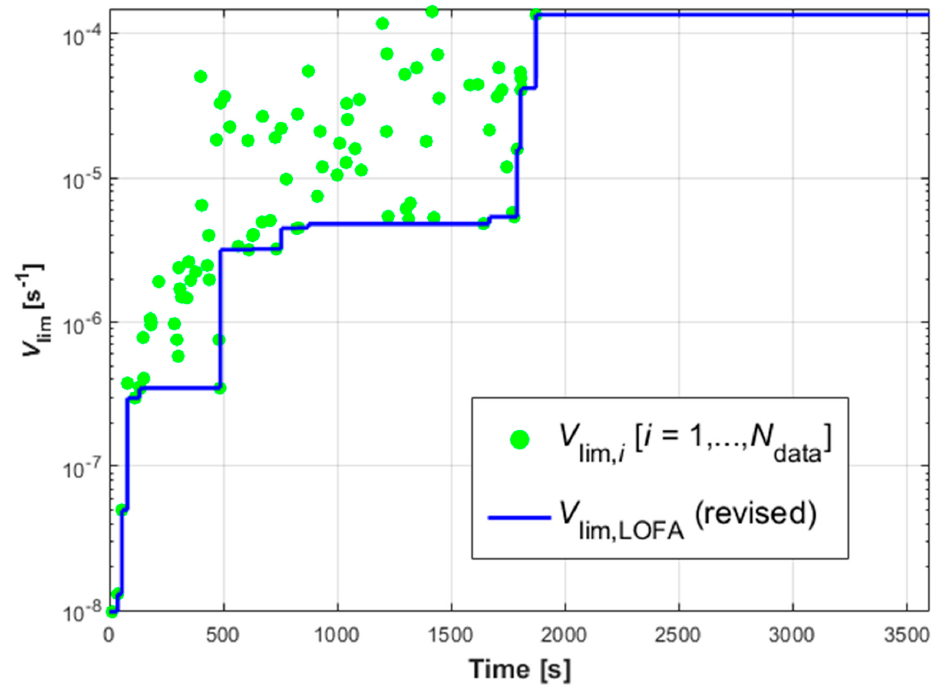
Figure 13. (cid:1848) (cid:3039)(cid:3036)(cid:3040),(cid:3013)(cid:3016)(cid:3007)(cid:3002),(cid:3039) trend in logarithmic scale (blue line) and (cid:1848) (cid:3039)(cid:3036)(cid:3040),(cid:3036) values used to estimate it (green points). Figure 13. V lim , LOFA , l trend in logarithmic scale (blue line) and V lim , i values used to estimate it (green Table 1. Optimal values of (cid:1842) (cid:3013)(cid:3016)(cid:3007)(cid:3002),(cid:3039)(cid:3036)(cid:3040) and (cid:1842) (cid:3007)(cid:3002)(cid:3010)(cid:3013),(cid:3039)(cid:3036)(cid:3040) ((cid:1857)) .